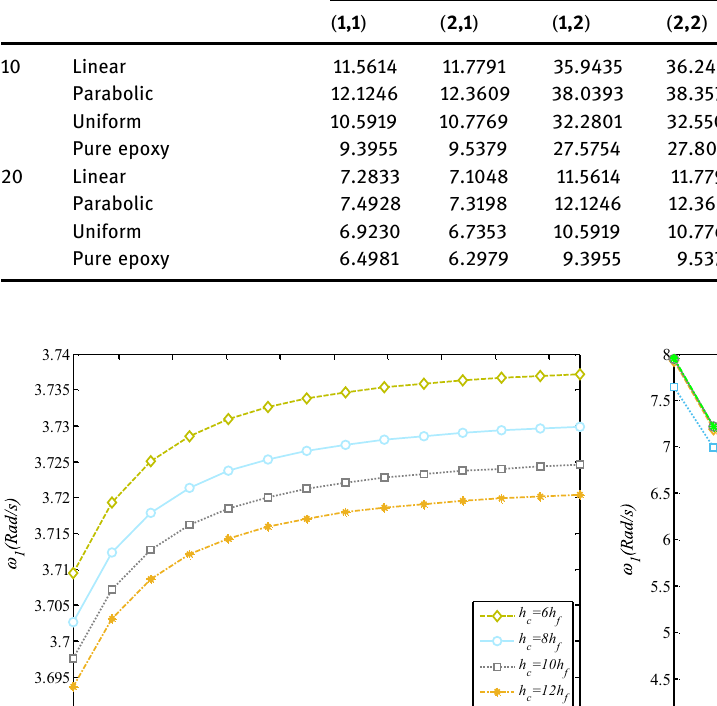
Table 4: E ff ect of GNPs dispersion pattern on the frequencies of the cylindrical shell for various wavenumbers L / h GNPs dispersion pattern